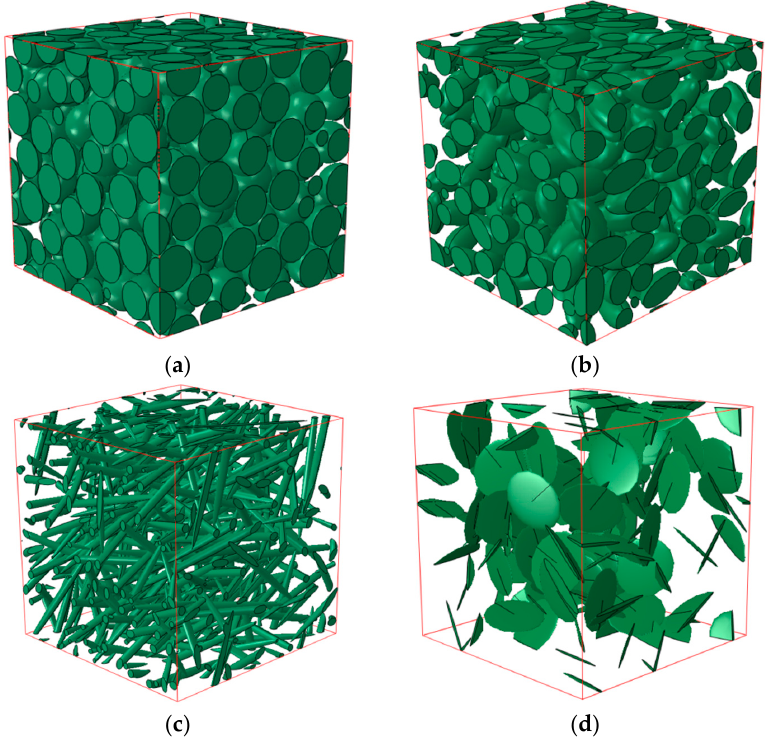
Figure 7. Representative volume element (RVE) samples of different aspect ratios and volume fractions. ( a ) R 1 = R 2 = 1, N = 200, V f = 60%; ( b ) R 1 = R 2 = 2, N = 200, V f = 40%; ( c ) R 1 = R 2 = 20, N = 200, V f = 10%; ( d ) R 1 = R 2 = 1/20, N = 100, V f = 5%